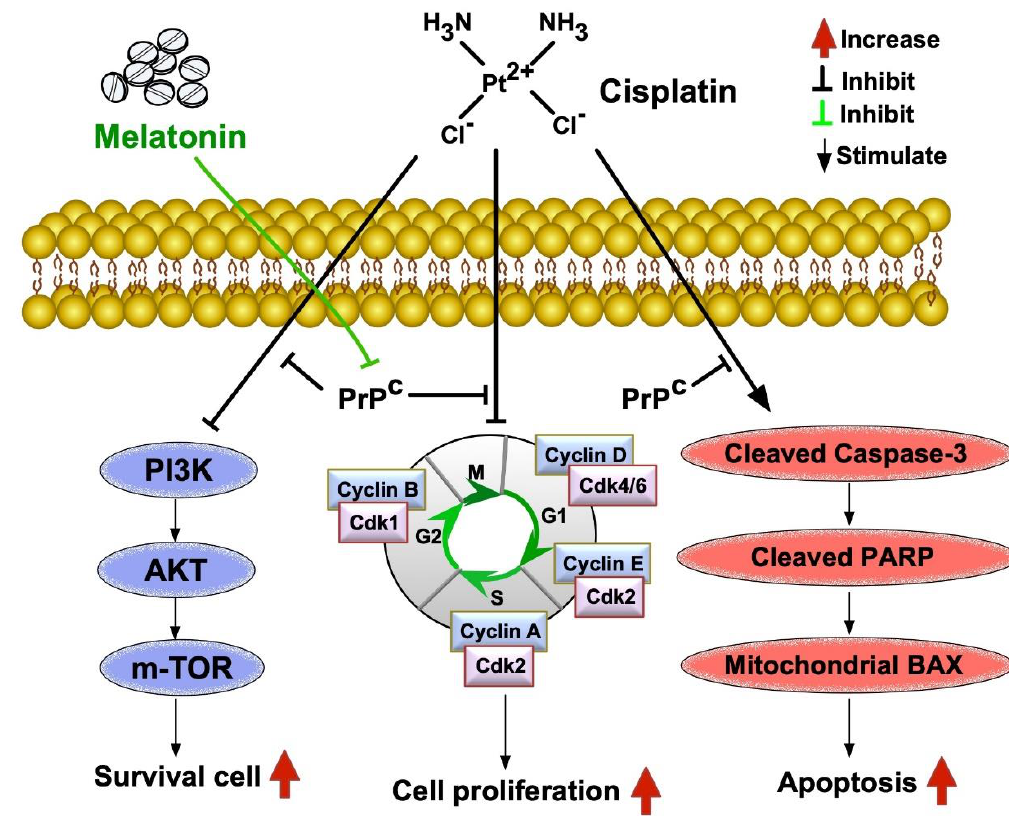
Figure 15. Schematically proposed mechanism suggests Mel-supported cisplatin in the treatment of bladder cancer cells. In this proposed mechanism, we suggest cisplatin effect would be attenuated by upregulation of PrP C expression in bladder tumors that could be suppressed by melatonin (Me), implying the Mel-facilitated cisplatin effect.